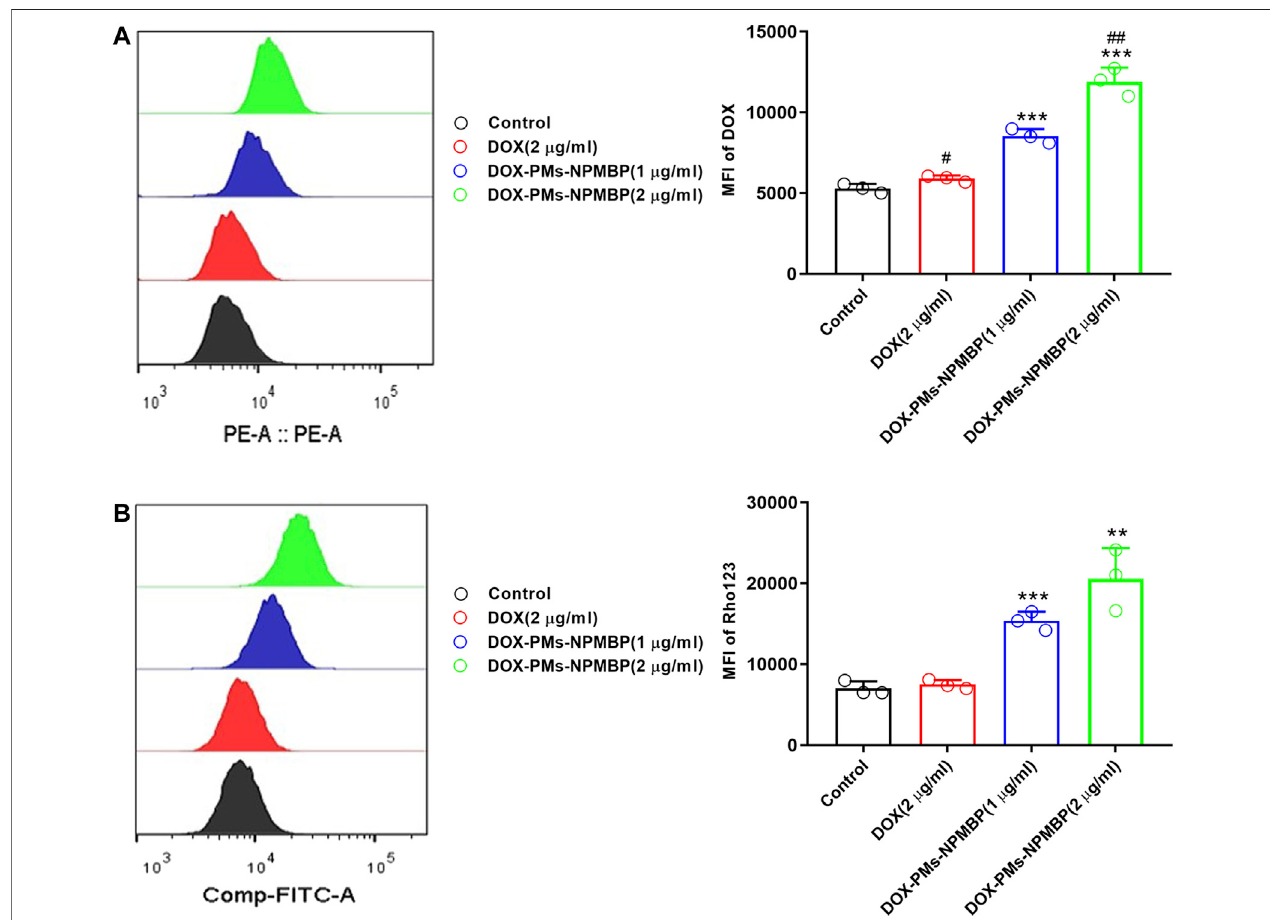
FIGURE 3 | DOX-PMs-NPMBP promotes intracellular accumulation of DOX or Rhodamine123 (Rho123) in Nalm6/DOX cells. Nalm6/DOX cells were treated with indicated concentration of DOX and DOX-PMs-NPMB for 12 h. The intracellular retention of DOX was evaluated by fl ow cytometry (A) . For the drug ef fl ux ability assay, Rho123 at2 μ Mwasaddedtoeach wellaboveand incubated foranother30 min at37 ° C.Afterwashed, fl owcytometeranalysiswasusedtoassesstheMFIofRho123 in the Nalm6/ADR cells through FITC channel (B) . Data re fl ect the mean ± SD of three separate experiments. MFI: mean fl uorescence intensity, ** p < 0.01, *** p < 0.001 compared with DOX, # p < 0.05 compared with control, ## p < 0.01 compared with DOX-PMs-NPMBP (1